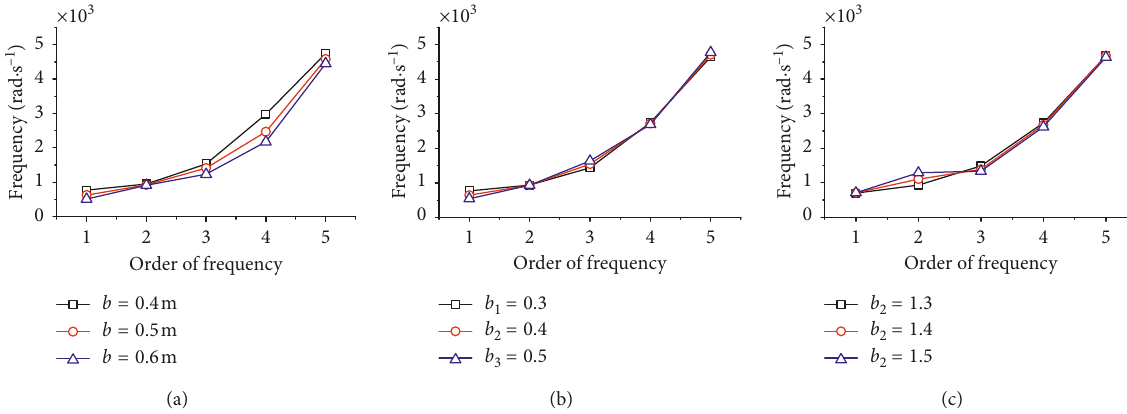
Figure 8: The effect of structure parameters on rotor natural frequency: (a) radius of the disk, (b) position of the first support, and (c) position of the second